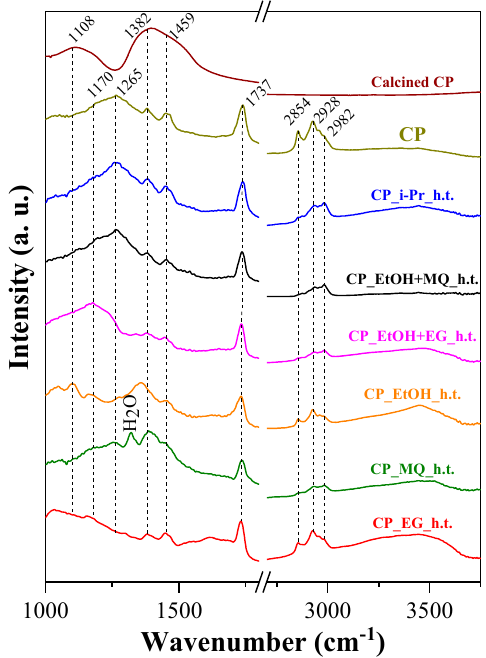
Figure 6. Infrared spectra of the BiOI coated papers marked the primary bindings of the ceramic paper and the epoxy resin. The different solvents and the solvent mixtures have no significant effects on the signals of the epoxy resin.